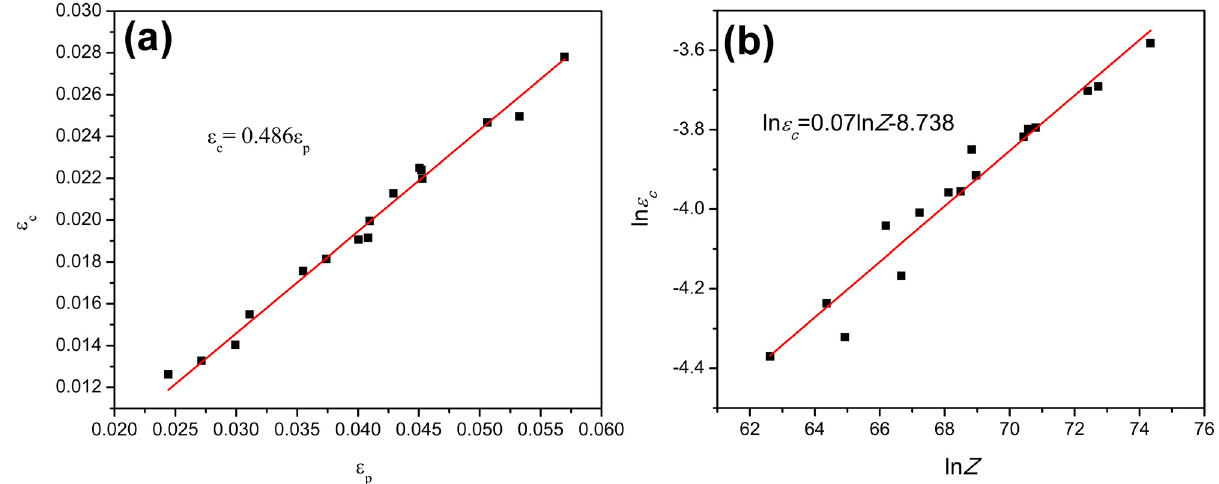
Figure 10: Relationship of ( a ) ε ε − c p and ( b ) ε Z ln −ln c .